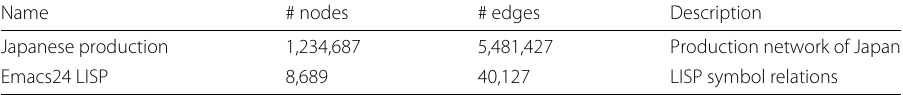
Table 3 Basic statistics of Japanese production network and Emacs24 lisp